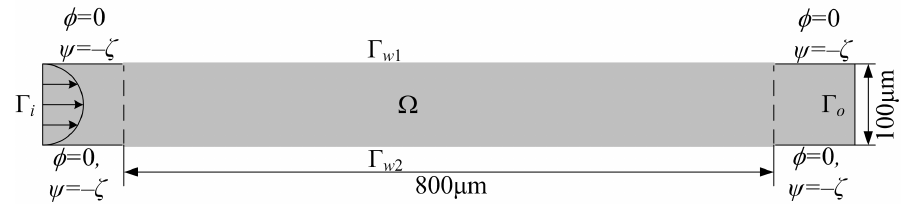
Figure 3. Schematic of the electroosmotic micromixer in a straight microchannel.